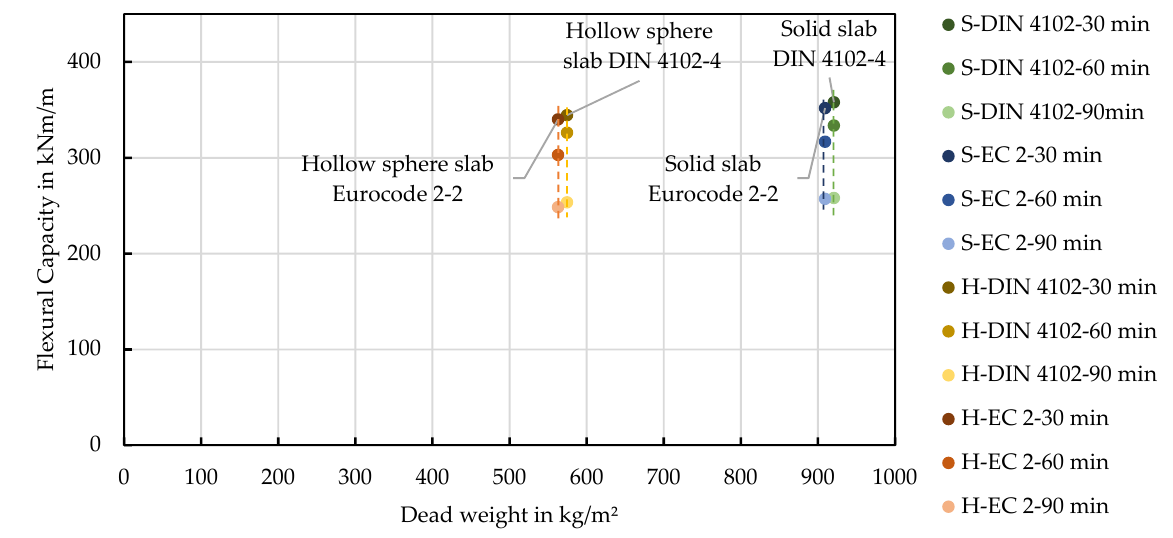
Figure 15. Dead weight—Flexural Capacity diagram of a solid slab (S) and hollow sphere slab (H) after 30, 60, 90 min fire exposure.